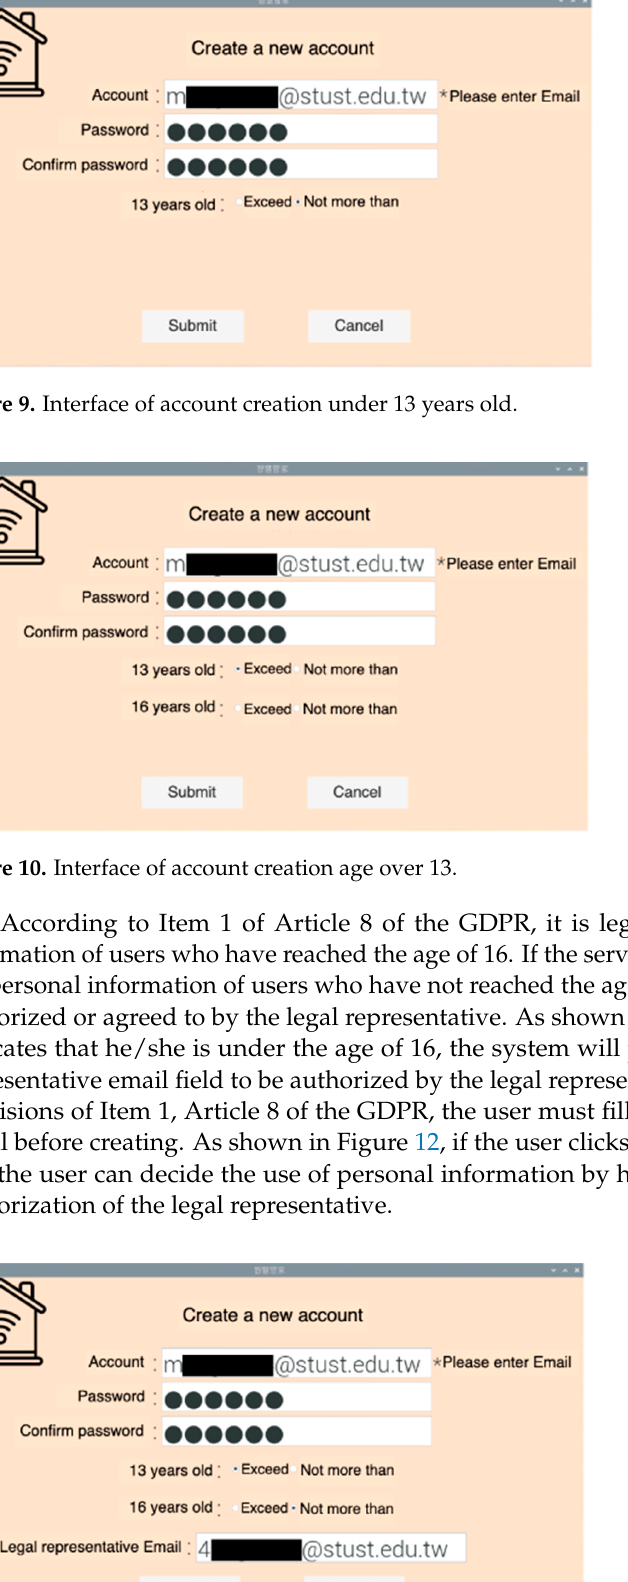
Figure 8. User operation interface.